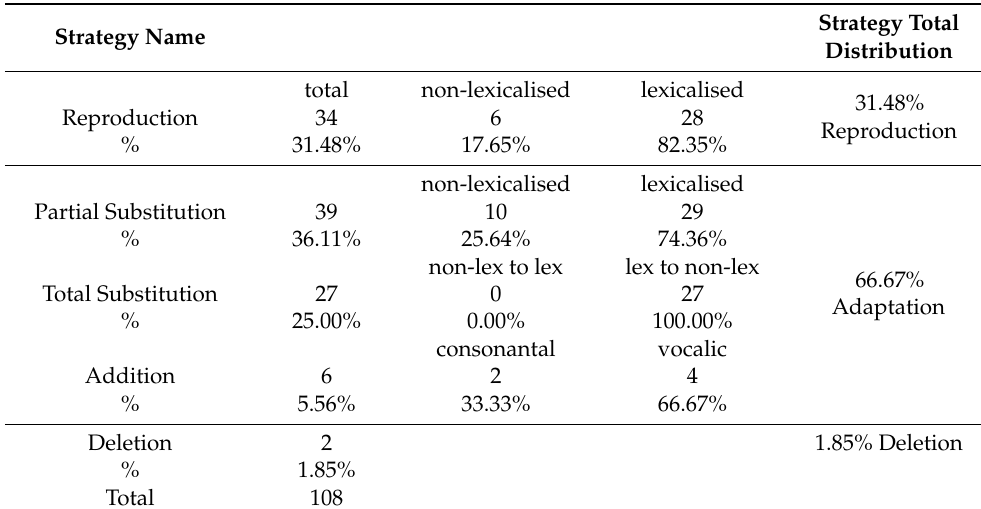
Table 5. Overall distribution of the five translation